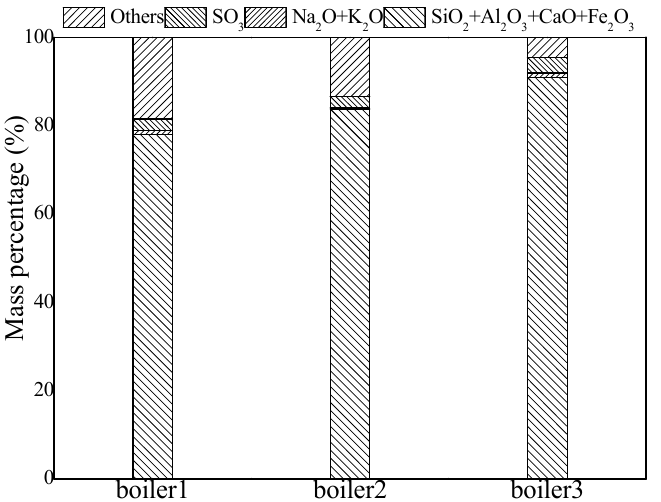
Figure 6. The percentage of representative elements contained in fine particles collected at the outlet of the furnace of a CFB boiler.